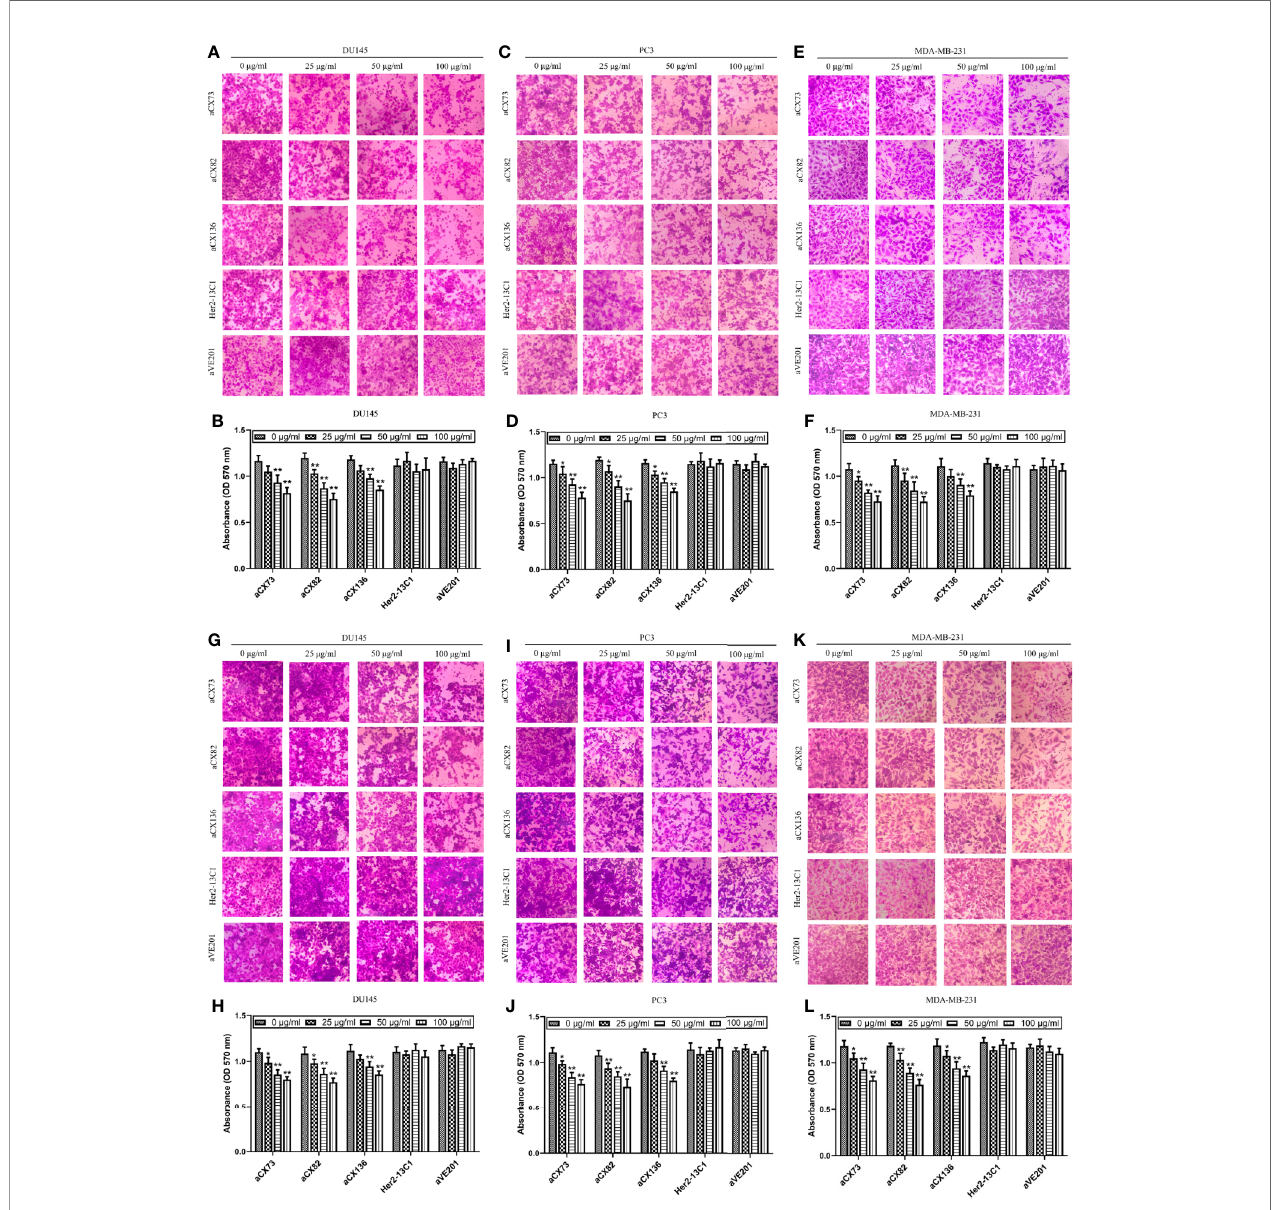
FIGURE 9 | Anti-CXCR4 scFvs can decrease cancer cell migration and invasion. To detect cell migration (A – F) , cells were incubated with CXCL12 (100 ng/ml) and the anti-CXCR4 scFvs (aCX73, aCX82, and aCX136) or two negative control antibodies. The cells that crossed over the membrane were treated with crystal violet, which was solubilized in acetic acid. Optical density was detected. (A, B) DU145; (C, D) PC3; (E, F) MDA-MB-231. For the detection of cell invasion, matrigel was placed in transwells, and then, cells were added. (G, H) DU145; (I, J) PC3; (K, L) MDA-MB-231. The results represent mean ± S.D (n = 5). * P < 0.05 and ** P <